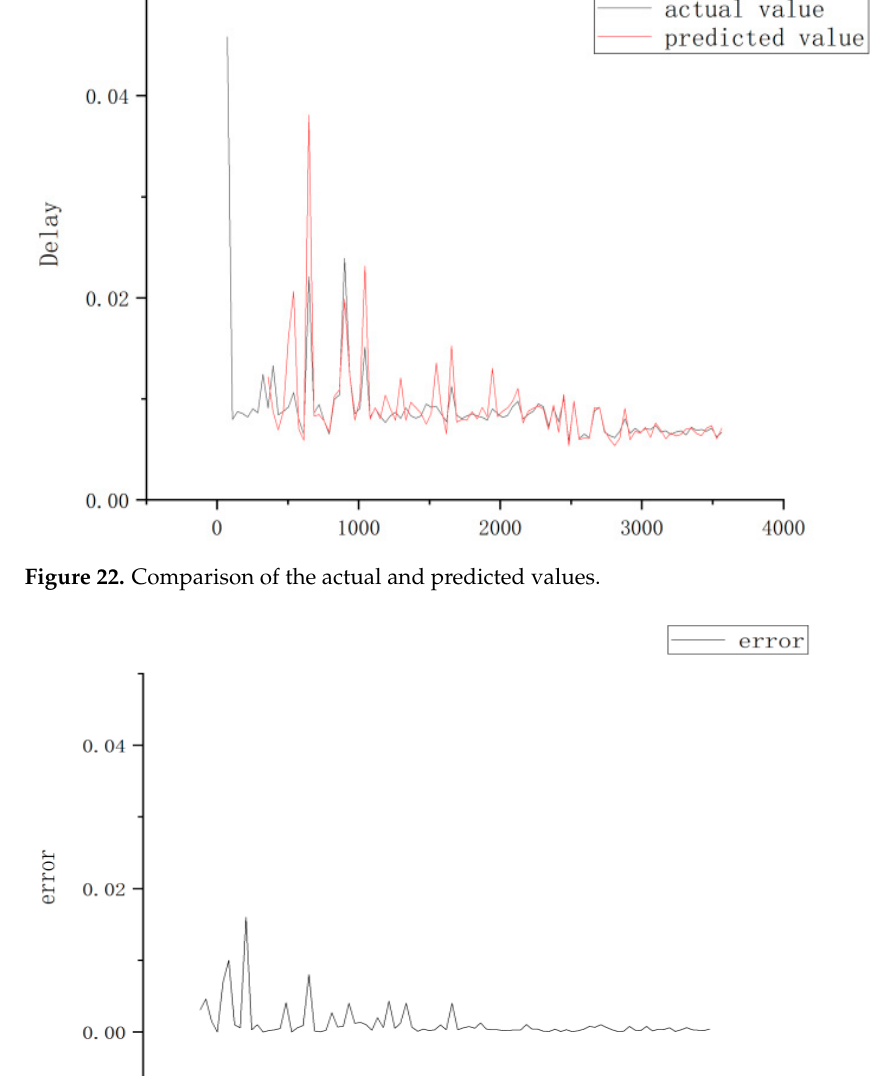
Figure 23. Error between the actual value and predicted values.